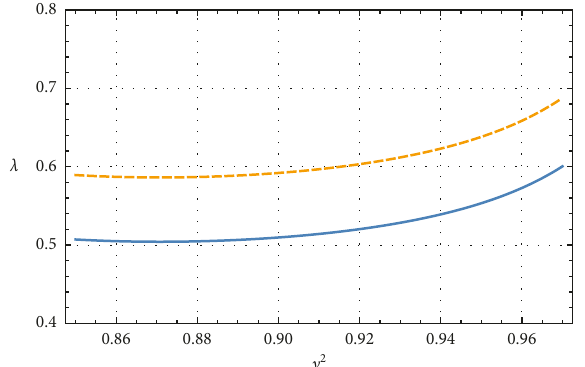
Figure 1: Values of the coupling constant, λ , in terms of the parameter c 2 obtained in this work. The T critical temperature of 203K. The Coulomb pseudopotential values μ ∗ � 0 . 1 (solid line) and μ ∗ � 0 . 16 (dashed line) are taken. The ratio � 0 . 222. E / E ph F